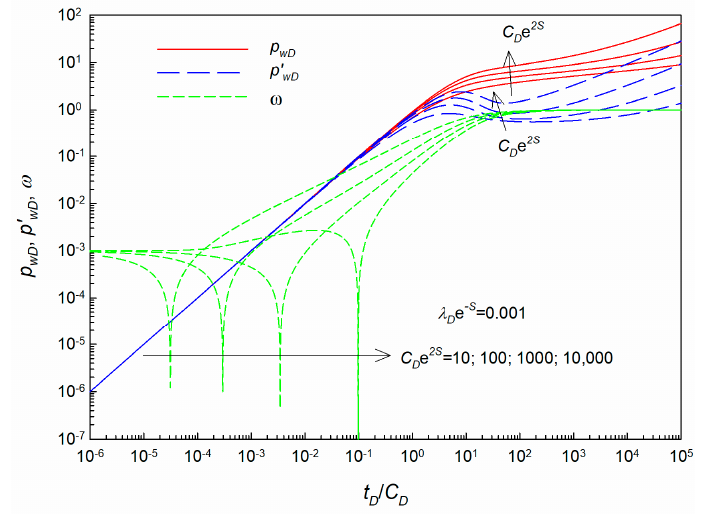
Figure 8. Effect of C D e 2S on the new type curves for non-Darcy flow model.